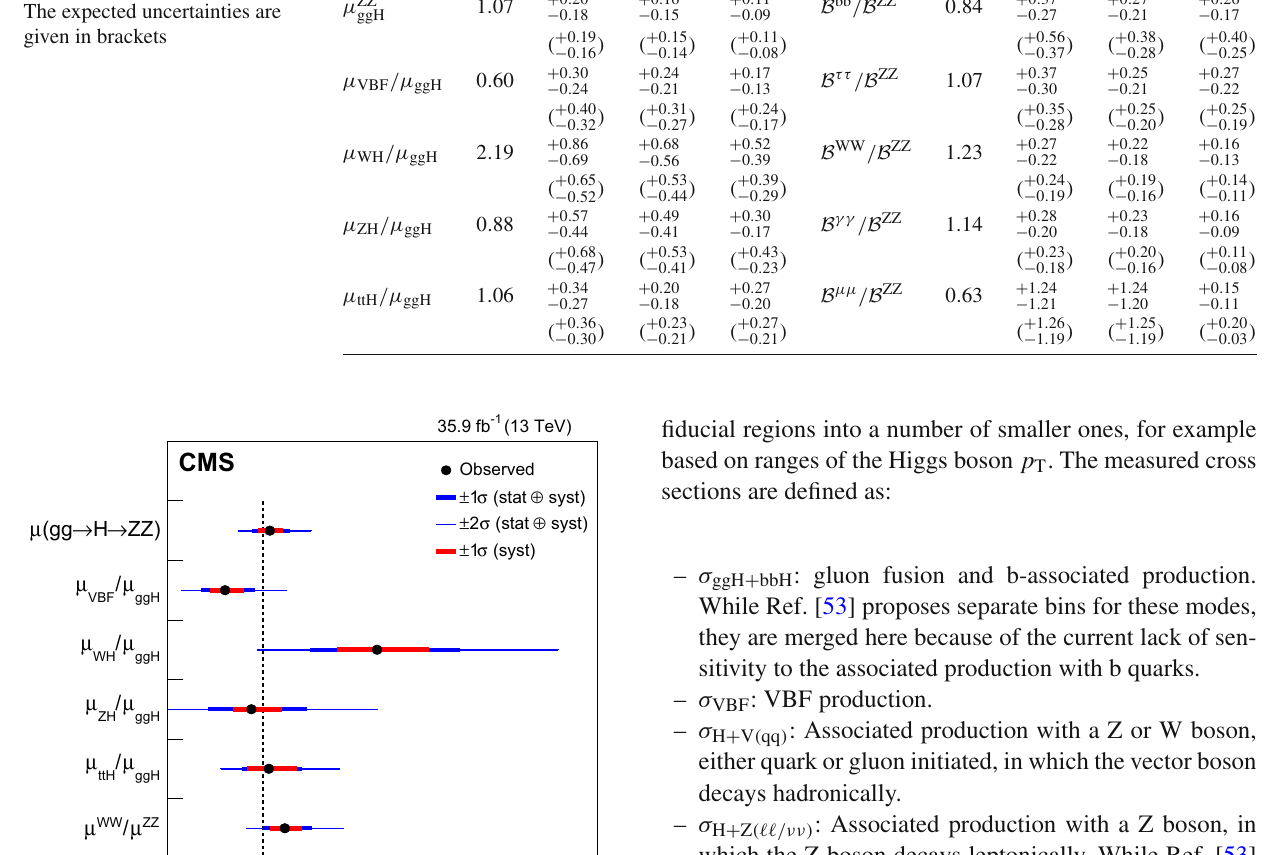
Table 4 Best fit values and ± 1 σ uncertainties for the parameters of the cross section and branching fraction ratio model. The expected uncertainties are